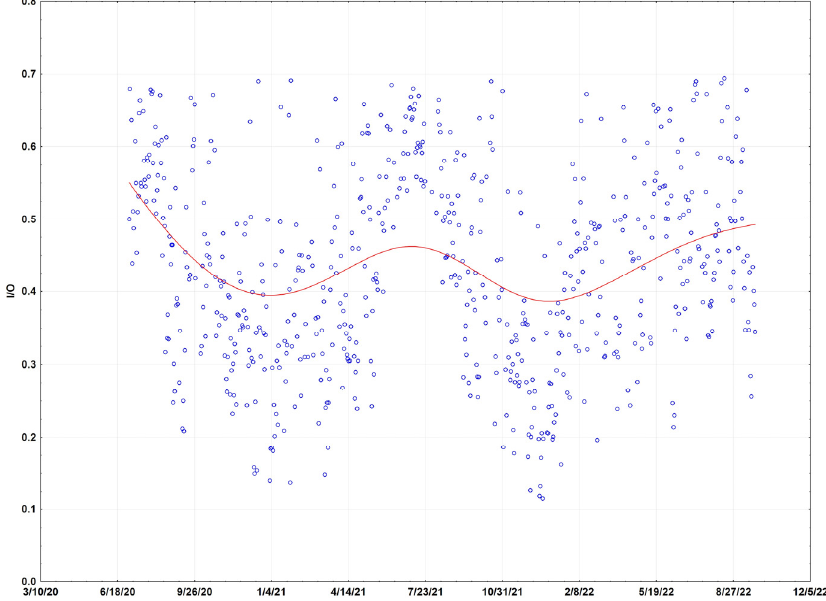
Figure 4. Indoor-outdoor (I/O) ratio of daily means at the Santa Rosa site. Data have been fit (red line) using distance-weighted regression.